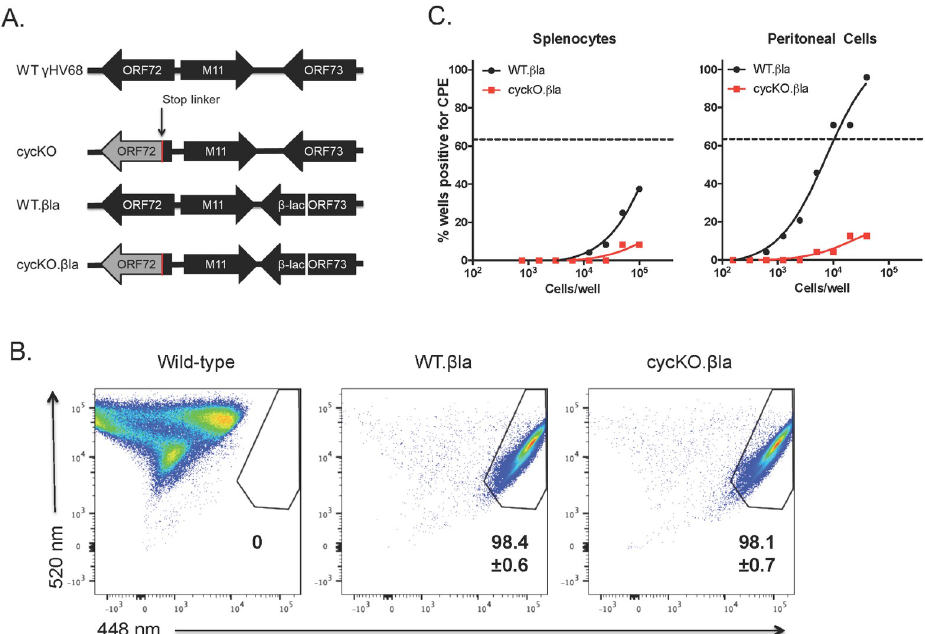
Fig 1. Characterization of the cyclin-deficient virus expressing a LANA β -lactamase gene fusion. (A) Schematic of wild-type virus (top), the cyclin deficient virus (second), the wild-type β -lactamase marked virus (third), and the cyclin deficient β -lactamase marked virus (bottom). Viruses described as in van Dyk 2000 and Niemeyer 2018. (B) Identification of infected cells by flow cytometry using β -lactamase ( β la). 3T12 cells were infected with either wild-type unmarked γ HV68, WT. β la, or cyckO. β la at an MOI of 10 pfu/cell. Cells were harvested at 12 hpi and infected cells were identified by β -lactamase activity. LANA:: β la+ cells are contained within the upper right polygonal gate. Average LANA:: β la+ frequencies are indicated +/- SEM n = 2. (C) B6 mice were infected via IP infection with WT. β la (black) or cycKO. β la (red) viruses. At 42 dpi splenocytes (left panel) and peritoneal cells (right panel) from infected mice were plated on MEFs in a limiting-dilution fashion. Comparison of reactivation from infected cells were pooled for reactivation analysis. For each virus group 5 mice were infected and pooled for reactivation analysis.